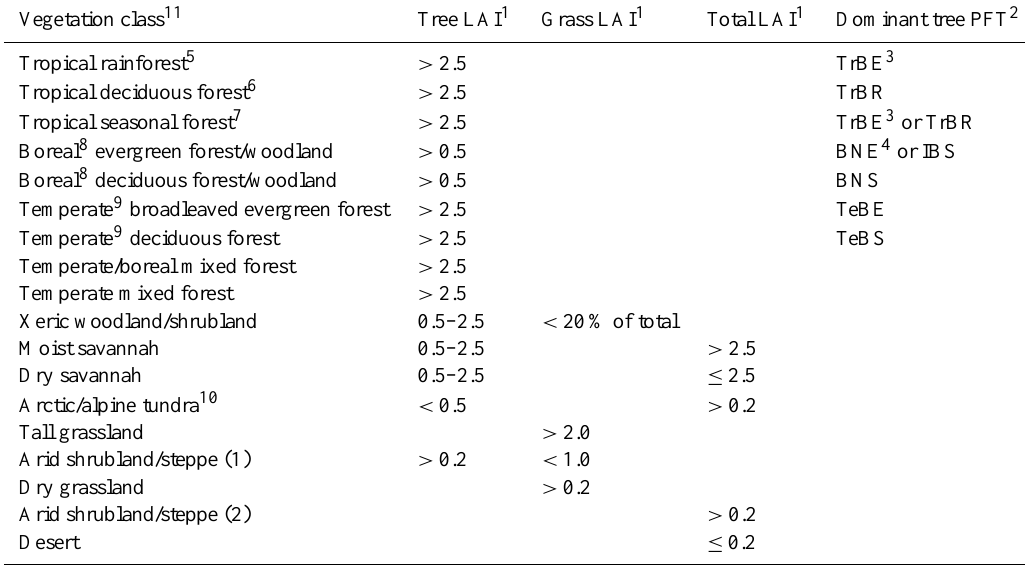
Table A1. Classification scheme for deriving vegetation classes (biomes) from PFT abundances for construction of Fig. 2 (modified from Hickler et al.,